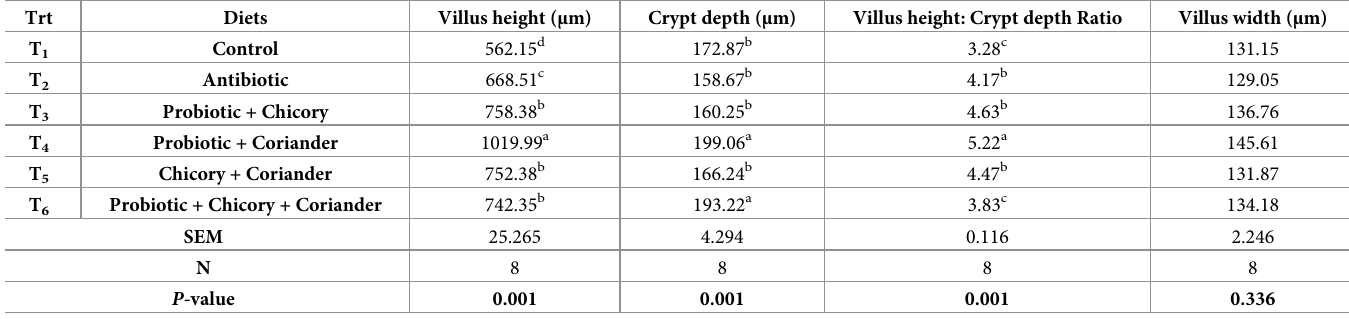
Table 11. Synergistic effect of probiotic, chicory root powder and coriander powder on histomorphometry of ileum of broiler chicken.